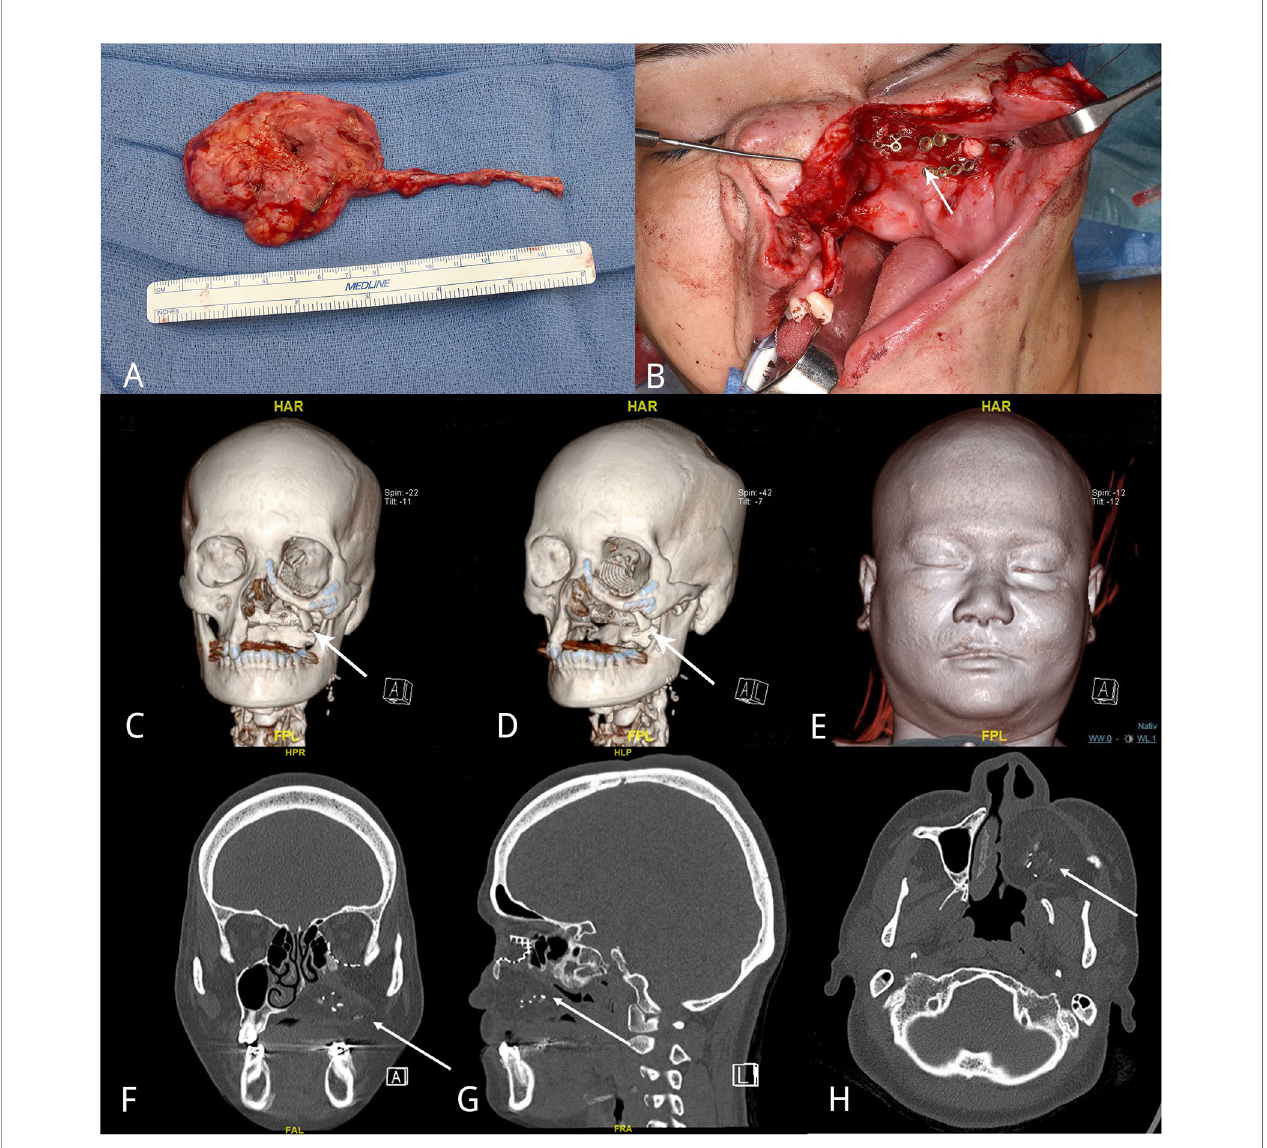
FIGURE 4 | Orthotopic graft transfer and follow-up imaging. Free tissue transfer of the engineered bone-soft tissue composite was performed 9 months after the fi rst step of prefabrication. (A) Harvesting of the composite graft, consisting of wrapped latissimus dorsi muscle and the engineered vital bone germ and the AV- bundle. (B) Transfacial incision. Exposure of the defect after removal of PEEK implant. (C, D) Tabula externa (white arrows) struts served as a substitute for missing bone parts in order to reconstruct the infraorbital rim. (E) 3D rendering with symmetric soft tissue coverage. Follow-up CT-imaging 24 months after the orthotopic transfer of the graft from (F) coronary, (G) sagittal, and (H) transverse views. The arrows point to the reconstructed bone tissue present after 24